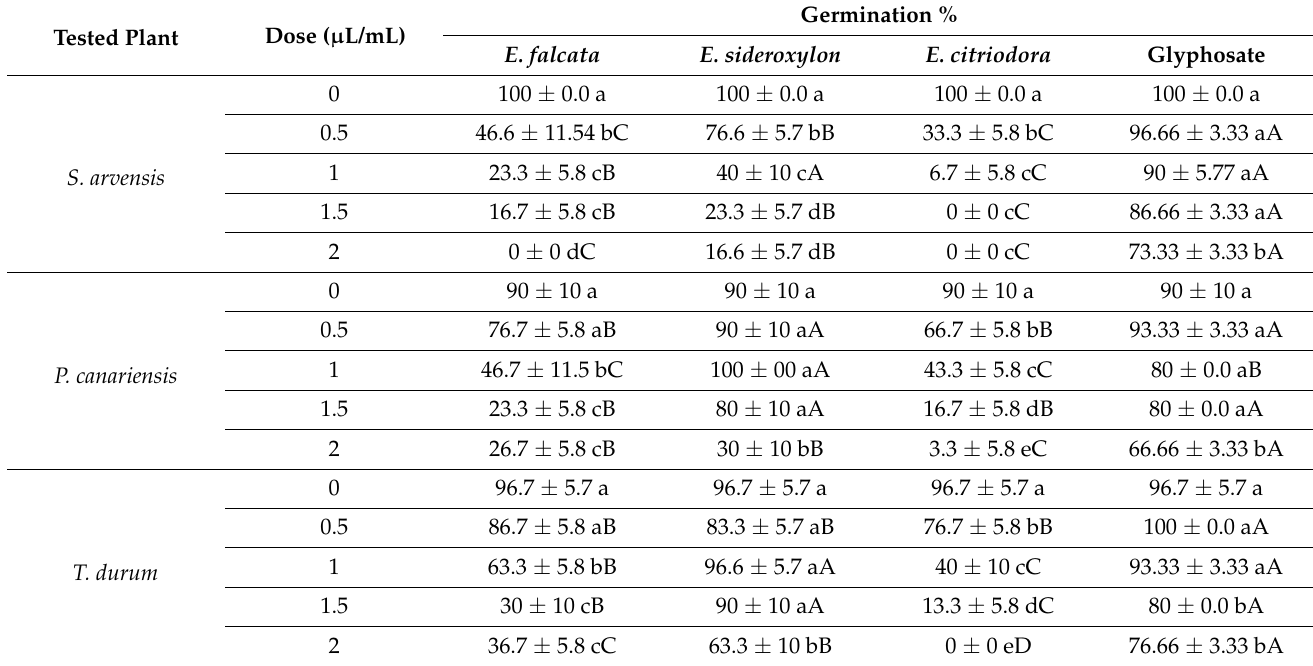
Table 4. Inhibitory effect of Eucalyptus species EOs on seed